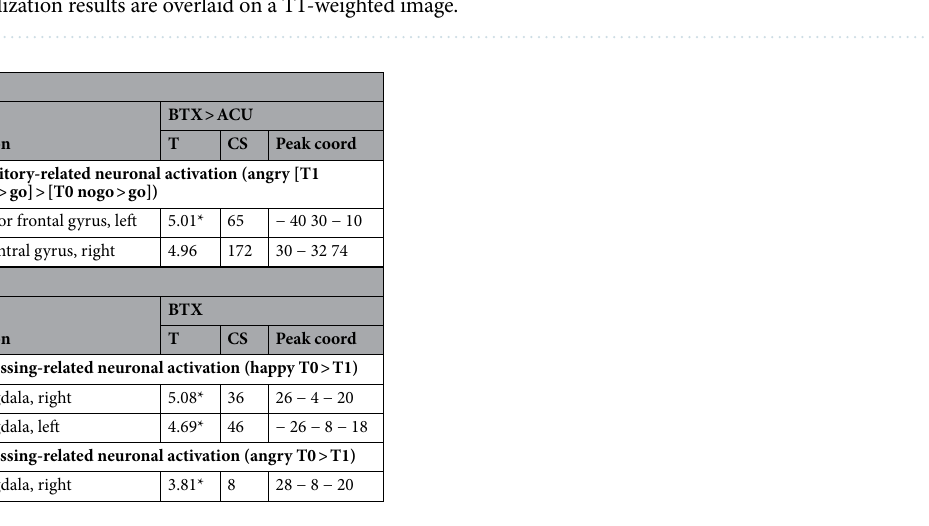
Table 2. BOLD activation peaks: shown are the peak activations, cluster size, t-value and corresponding AAL labels for the following contrasts. (A) Peaks in the direct contrast BTX > ACU. (B) Peaks for the BTX group only. BTX incobotulinumtoxinA, ACU acupuncture, CS cluster size, Peak coordinates of clusters are according to the MNI-space (Montreal Neurological Institute), T t-score of peak voxel, FWE correction with p < 0.05 at whole-brain level, T-values marked with * are corrected using small volume correction (SVC) in a-priori regions of interest (see “Methods”) at an FWE corrected level of p <